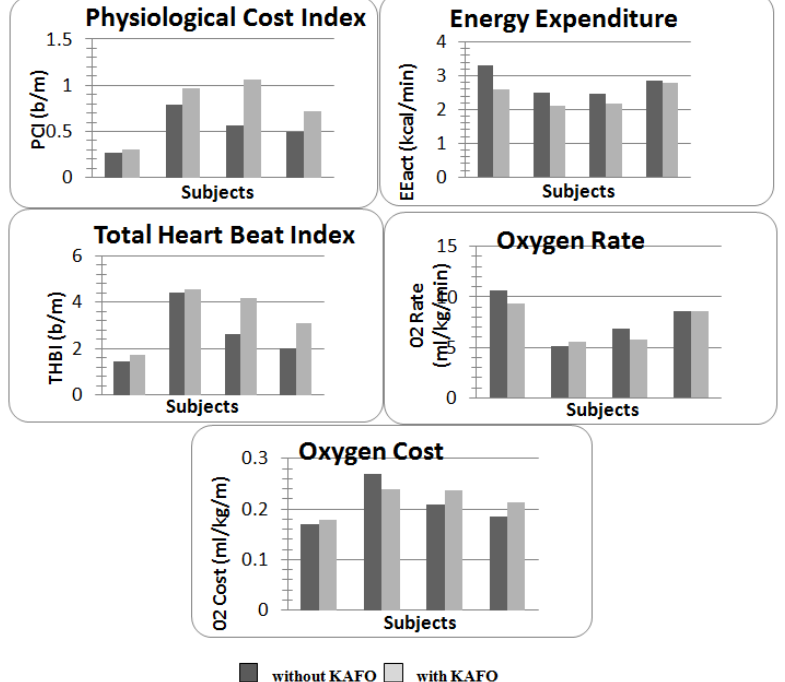
Figure 6. Comparison of the energy expenditure indexes evaluated through the ICG/ECG and acceleration signal. Light grey and dark grey were used to discriminate between the trials carried out with and without the orthosis,